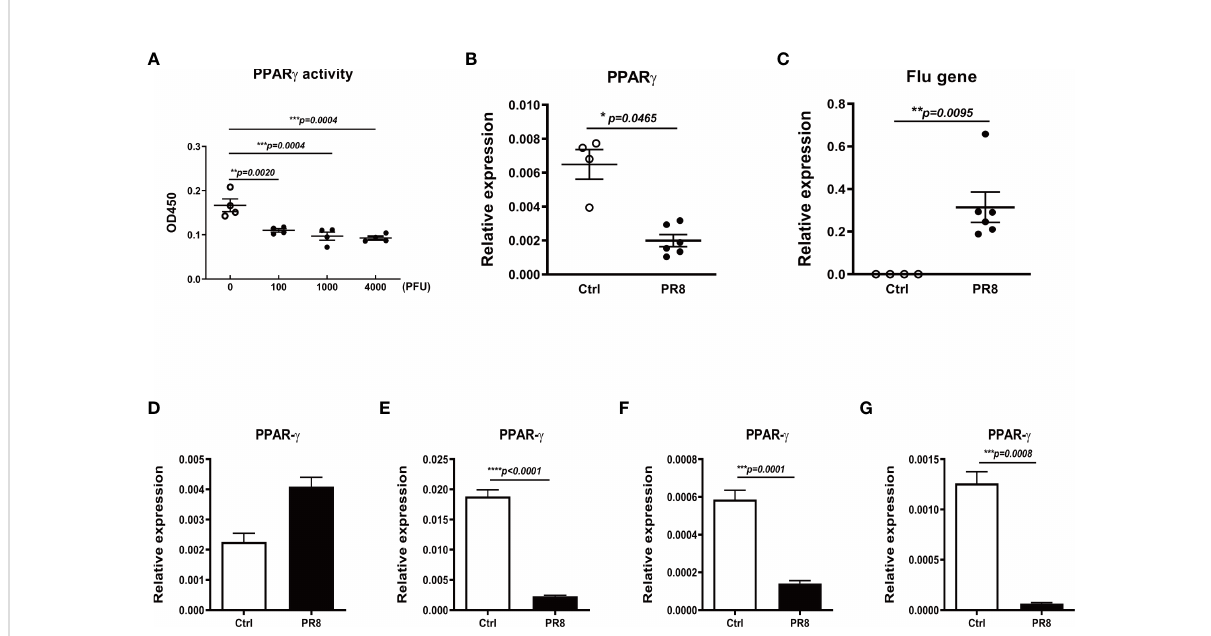
FIGURE 4 In fl uenza infection reduces PPAR g expression and activity in mouse lungs and macrophages. C57B/6 mice were infected with different doses of PR8 or saline by intranasal inoculation, and the lung tissue was collected on day 3 after infection. The PPAR g activity (A) and mRNA (B) in the mouse lung tissue were determined. The viral RNA in mice lungs was also determined by RT-PCR (C) . The isolated mouse lung alveolar epithelial type II cells (ATII (D) ), alveolar macrophages (AM (E) ), lung interstitial macrophages (IM (F) ), and bone marrow-derived macrophages (BMDM (G) ) were infected with PR8 at MOI=1, harvested the cell pellet at 24 h after infection for RNA extraction. The PPAR g mRNA was determined by RT-PCR. Unpaired t test was applied for the statistical analysis. *p < 0.05, **p < 0.01, ***p < 0.001 and ****p <